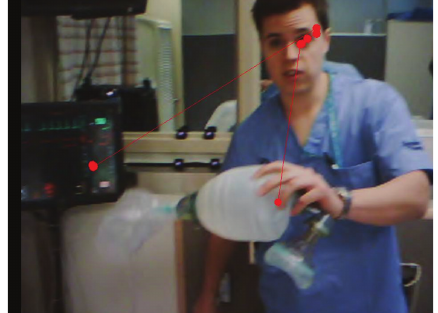
Figure 2: Screen shot of the first-person video recording with the superimposed dynamic gaze indicator (orange circles with connecting